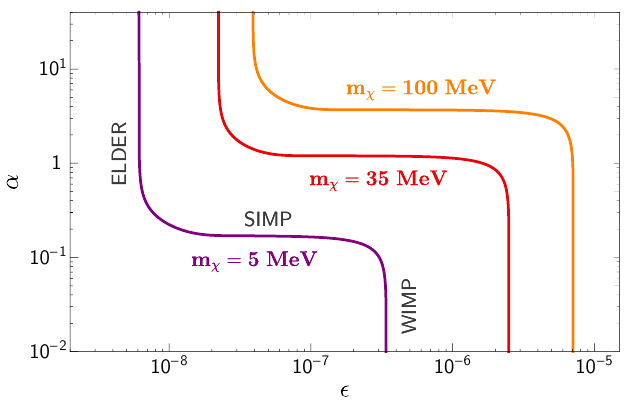
Figure 2 . Regions of parameters corresponding to the observed relic density. For each mass, the vertical section of the line of the left/top corresponds to the elastically decoupling relic (ELDER) scenario proposed in this paper; the horizontal line to the SIMP scenario; and the vertical section on the right/bottom to the WIMP scenario. This (cid:12)gure, reproduced from ref. [7], is based on a numerical solution of the Boltzmann equations for a model with g (cid:31) = 2, = photon, n = 0, c 0 = 8 (cid:25)(cid:15) 2 . The same behavior is observed in other models, see for example (cid:12)gure 6